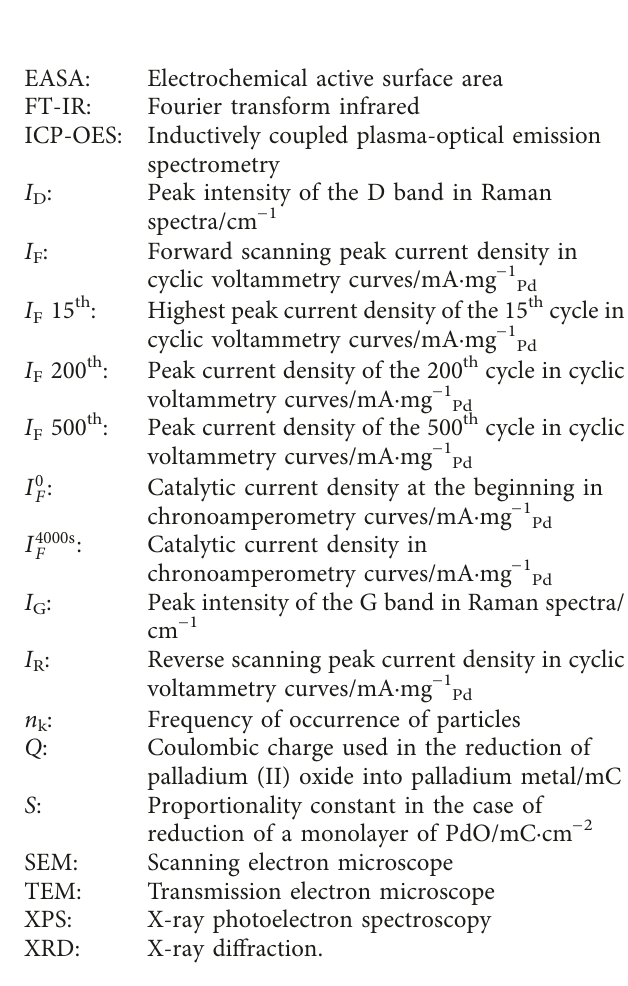
2 H 5 OH 1M) solution at a